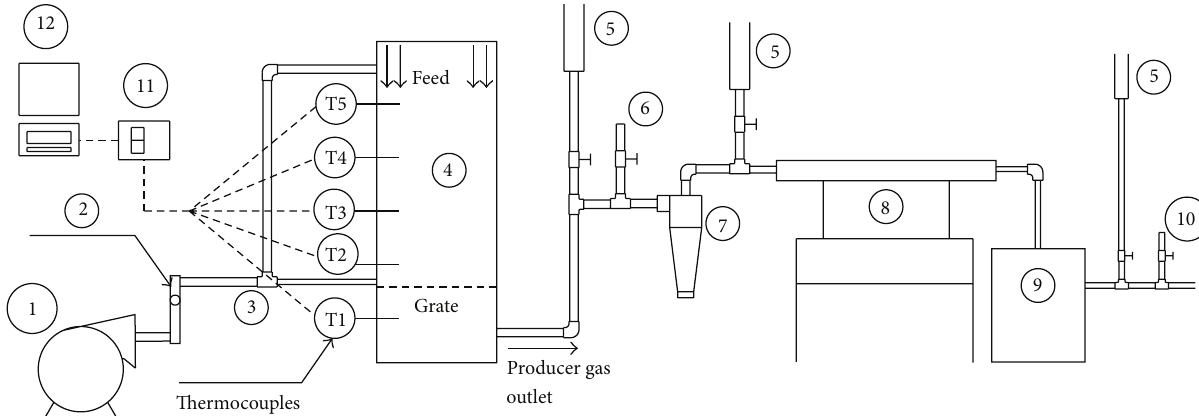
Figure 3: Schematics of the experimental setup: (1) air blower, (2) rotameter, (3) air distribution line, (4) downdraft gasifier, (5) gas flare points, (6) raw gas ampling point, (7) cyclone for gas cleaning, (8) cooling heat exchanger, (9) oil bath filter, (10) clean gas sampling point, (11) temperature data logger, (12) computer.